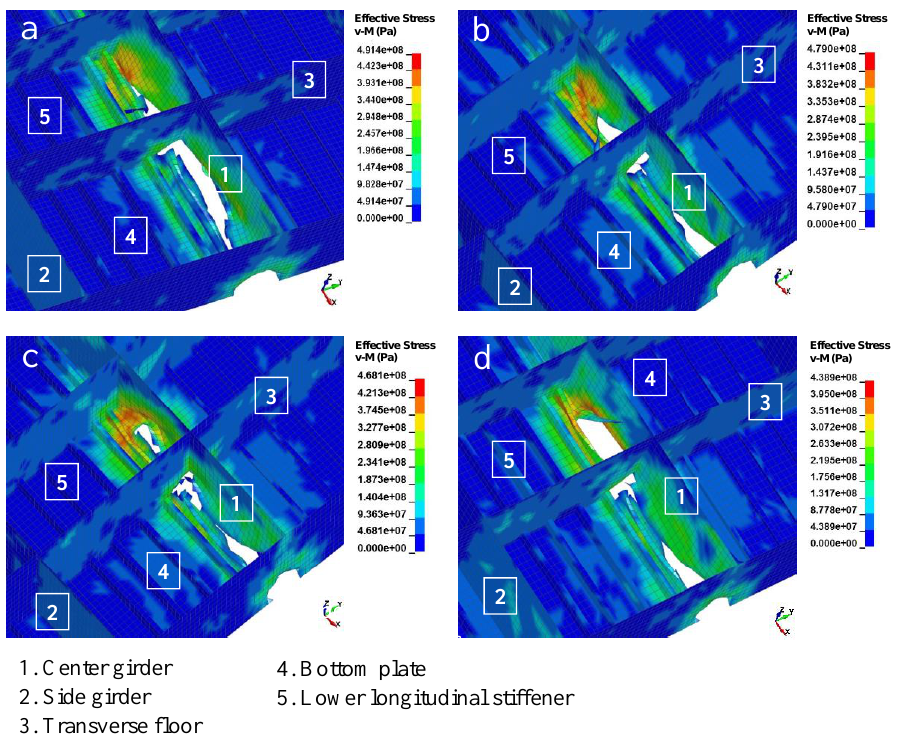
Figure 13: Stress contours using the von Mises (v-M) criterion on different mesh sizes: (a) 120 mm, (b) 132 mm, (c) 144 mm, and (d) 156 mm.